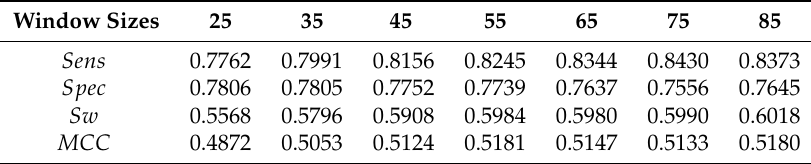
Table 1. Performance with different long